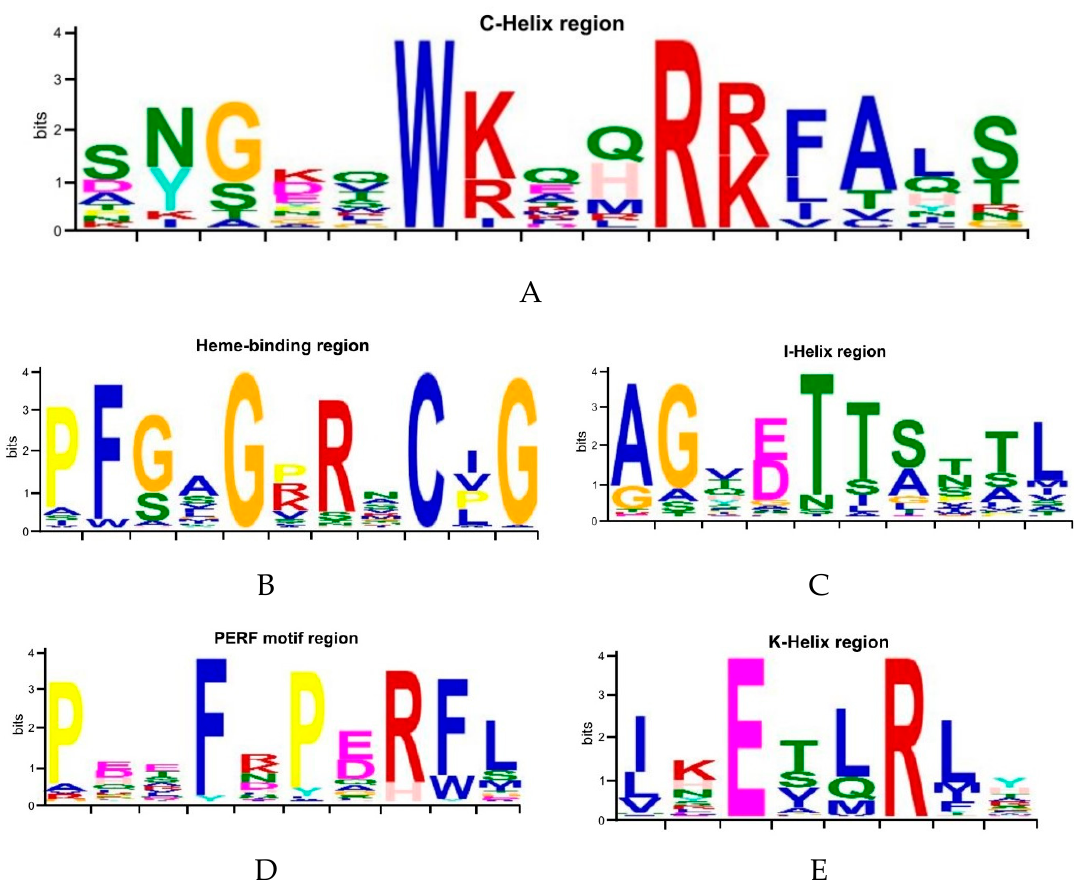
Figure 2. Motif and variation patterns among P. sinensis CYP genes. The height of a letter indicates its relative frequency at the given position for the amino acid. Five conserved regions are shown here: ( A ) C-helix region (WxxxR); ( B ) Heme-binding region (PFxxGxRxCxG/A); ( C ) I-helix region (GxE/DTT/S); ( D ) PERF motif region (PxxFxPE/DR); and ( E ) K-helix region (ExLR).